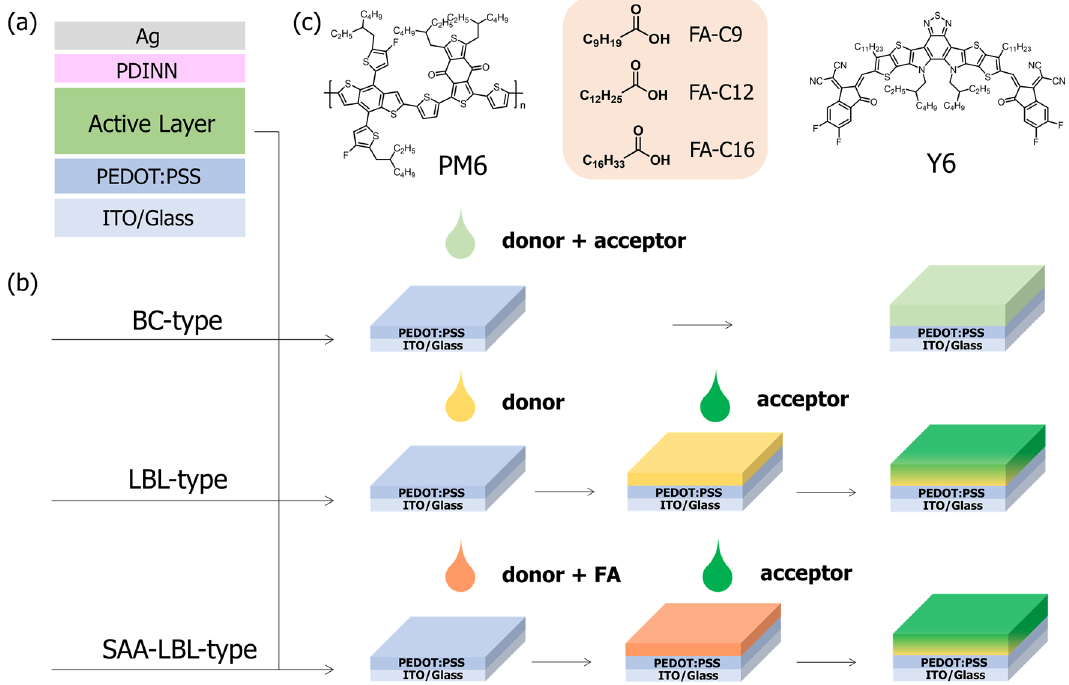
Fig. 1 a Diagram of conventional device structure of OSCs. b Diagrams of BC, LBL and SAA-LBL processing. c Chemical structures of PM6, Y6, and three FAs (FA-C9, FA-C12,